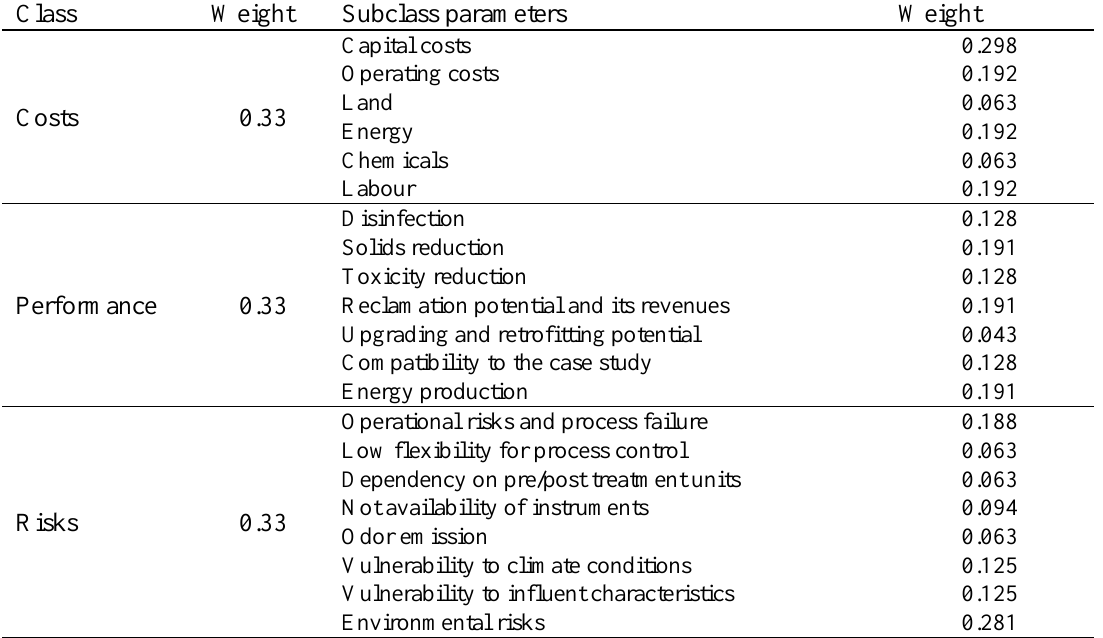
Table 2. Analysis parameters and their weights used in